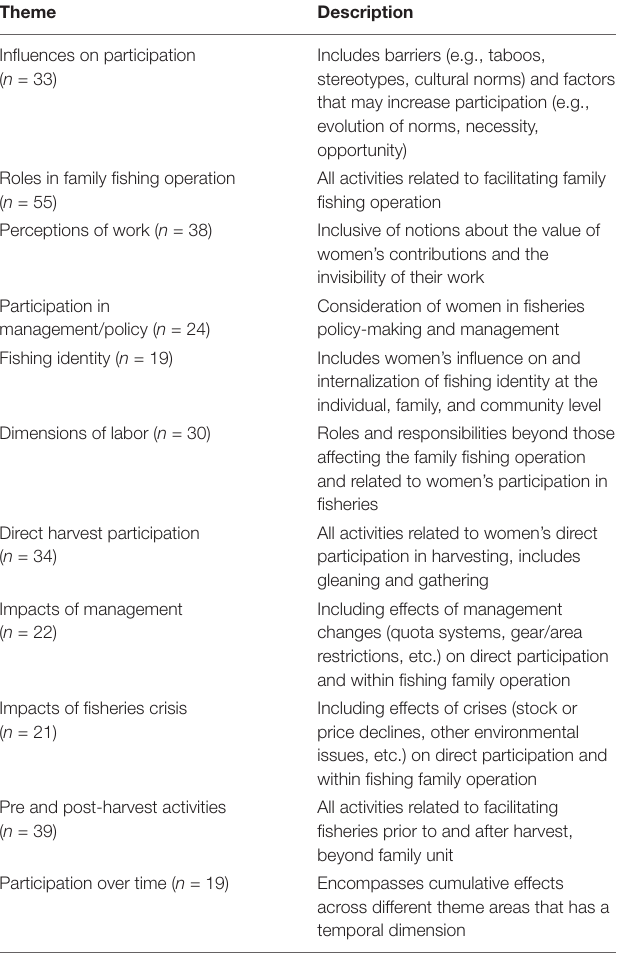
TABLE 1 | Major themes described in the literature on women’s participation in